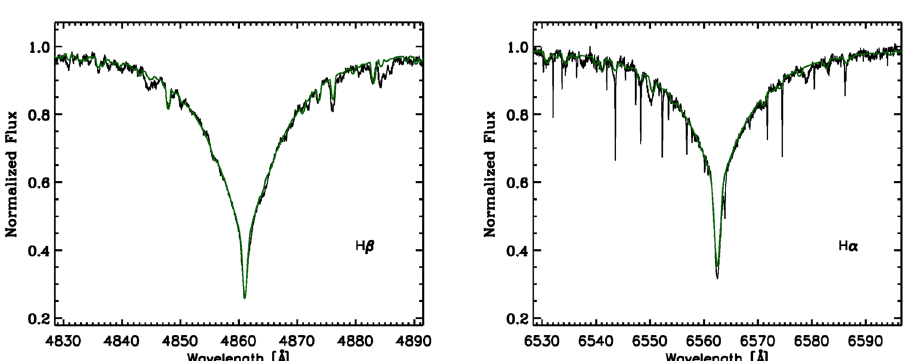
Figure 2. Observed hydrogen H α and H β lines (black lines) and best-fit synthetic profiles (green